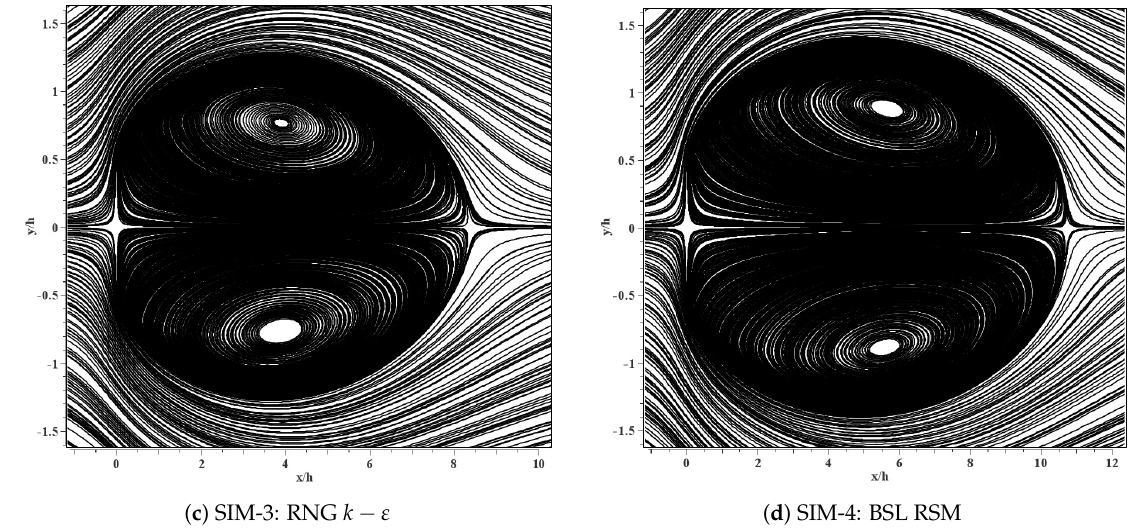
Figure 3. Streamlines plot of the wake central xy − plane from different RANS models at Re = 1200. Table 1. Comparing the mean drag coefficient and recirculation length for different turbulence model, with the Direct Numerical Simulation (DNS) results at similar Reynolds number ( Re =